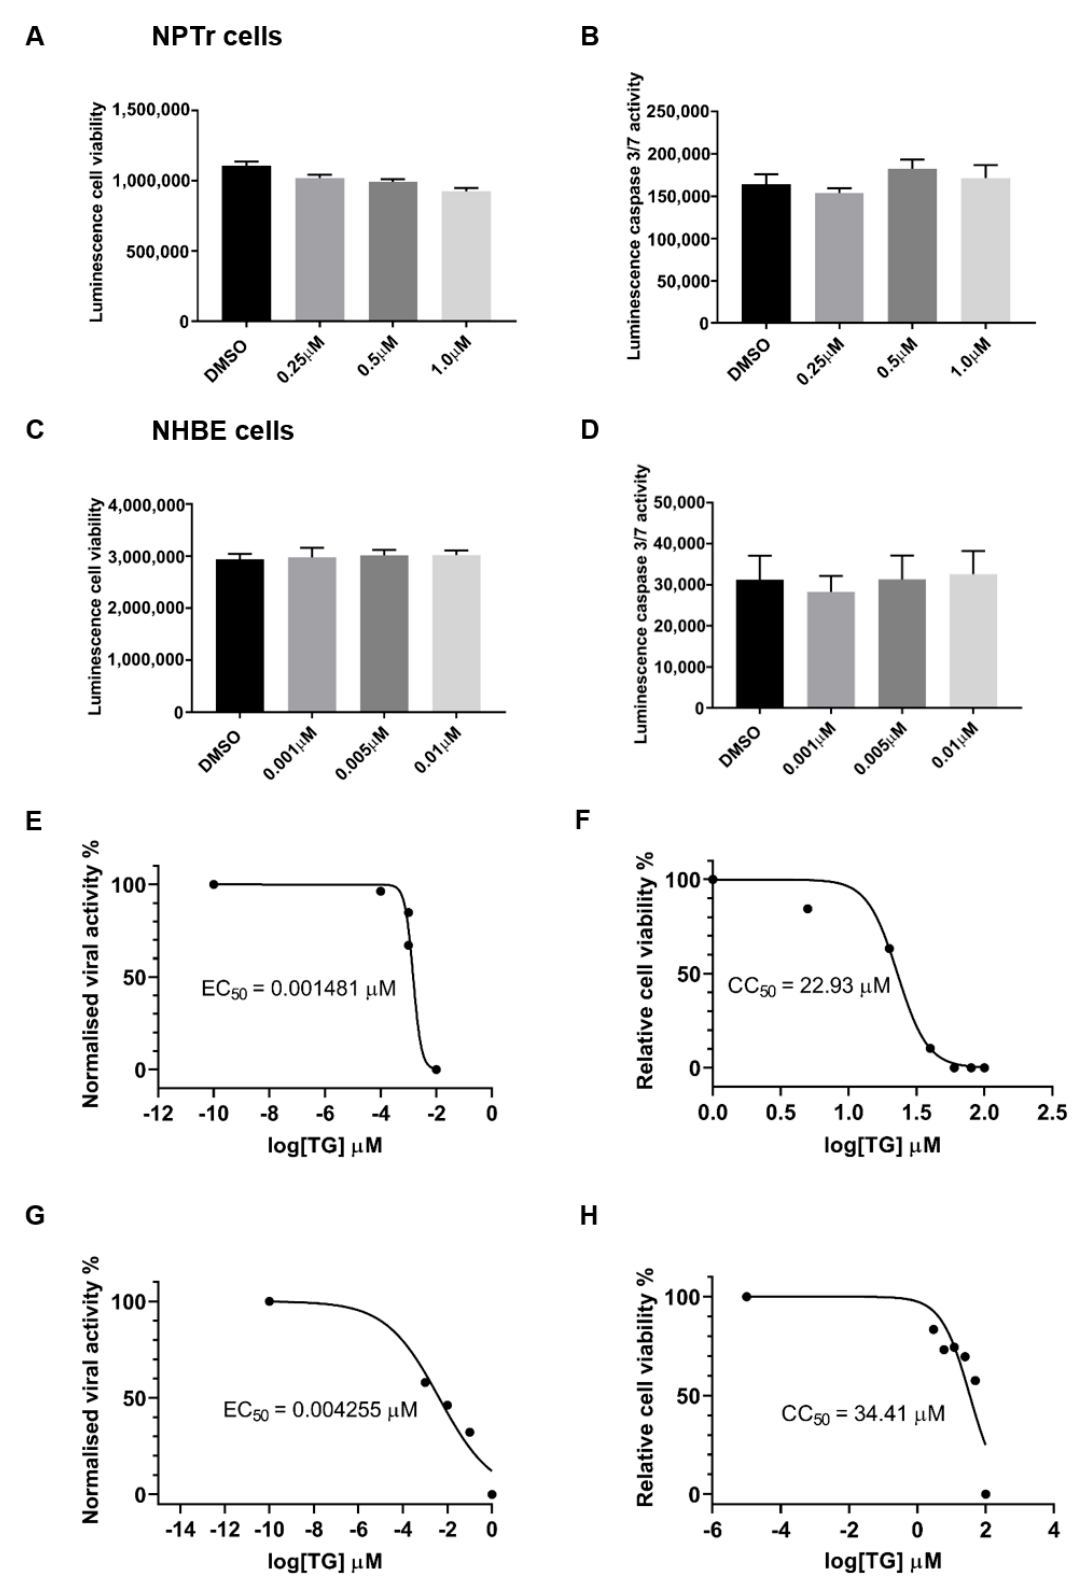
Figure 2. Priming with antiviral concentrations of TG displays no cytotoxicity in respiratory epithelial cells. ( A , B ) NPTr cells and ( C , D ) NHBE cells were incubated in indicated concentrations of TG or in DMSO control for 30 min and ( A , C ) cell viability assays (CellTiter-Glo luminescent cell viability assay) or ( B , D ) caspase 3/7 activity assays (Caspase-Glo 3/7 assay) performed 24 h later. Significance determined by one-way ANOVA, relative to DMSO control. No significant change in cell viability or caspase activity was found. ( E ) NHBE cells and ( G ) NPTr cells were incubated for 30 min in a range